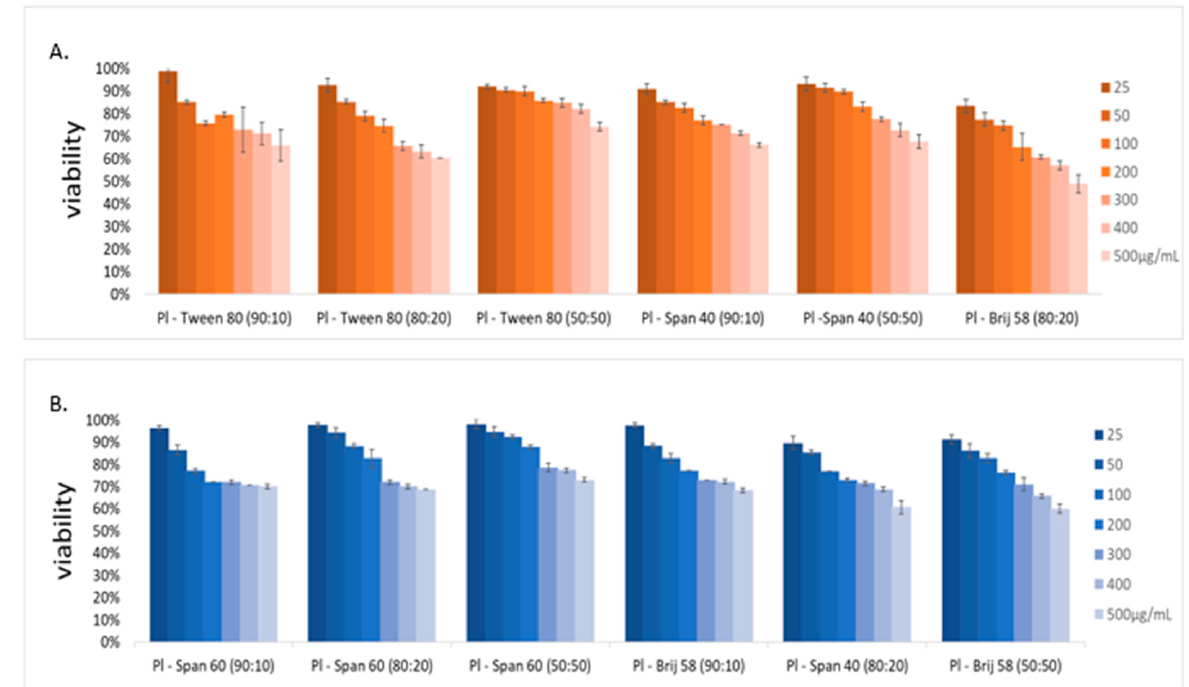
Figure 5. Cell viability vs. different concentrations of ( A ) Poloxamer 188-Tween 80 ® and Poloxamer 188-Span 40 ® and ( B ) Poloxamer 188-Span 60 ® and Poloxamer 188-Brij 58 ® at different weight ratios. Each graph accounts for the dispersion of the viability percentage via the standard deviation. Results after a 24-h incubation.